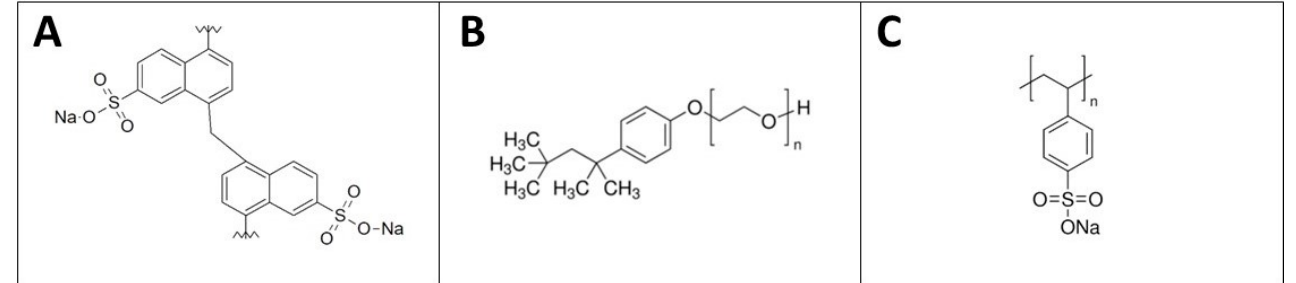
Figure 1. The chemical structures of poly(di-2-naftalensolphonate of sodium) (DNMS) ( A ), Triton X-100 ( B ), and poly(sodium 4-styrenesulfonate) (PSS) ( C ).